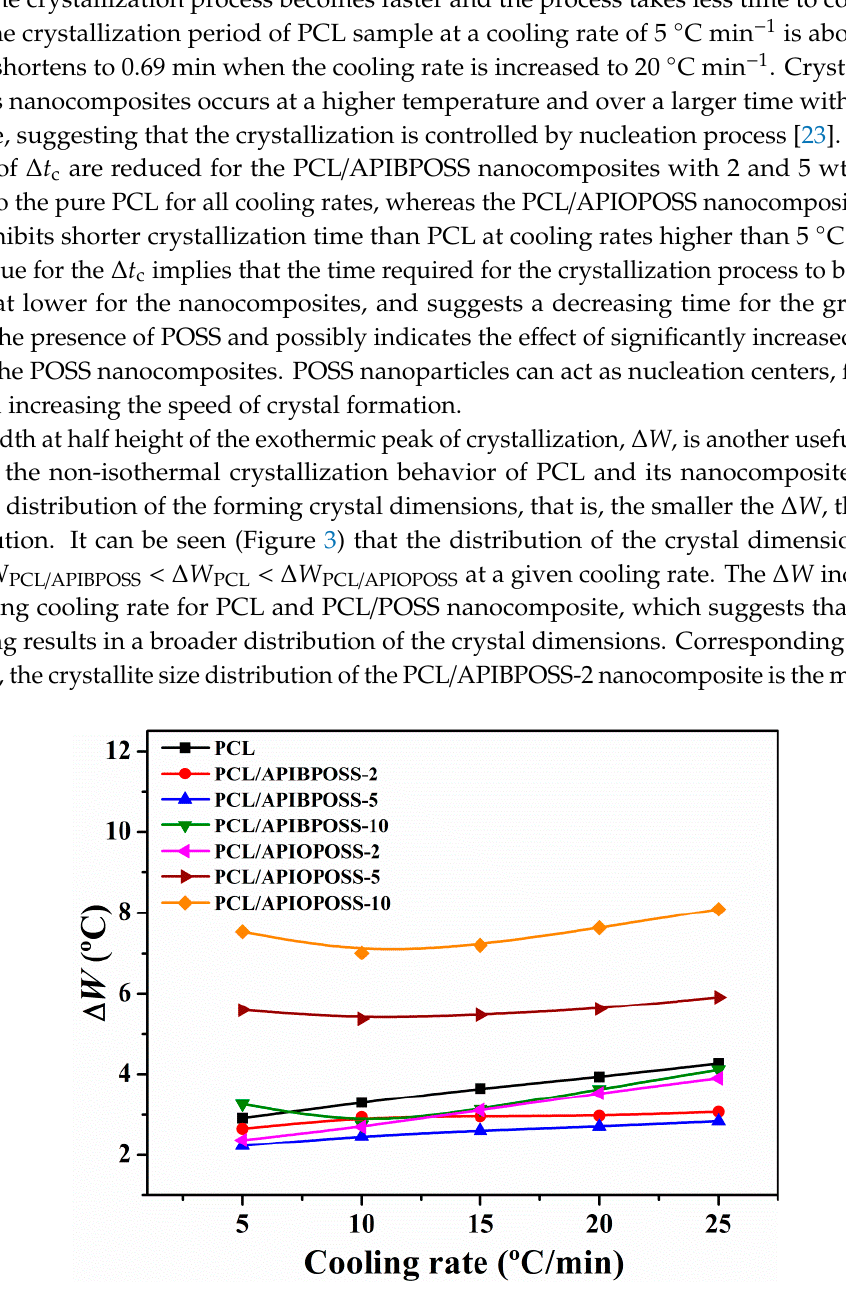
Figure 4. ( T k − T cp ) parameter as a function of cooling rate for PCL and PCL/POSS nanocomposites. Table 1 also shows the heat of crystallization ( Δ H c ). It is observed that the crystallization enthalpy is affected by both the addition of POSS and cooling rate. The values of Δ H c obtained for both neat PCL and PCL/POSS nanocomposite decrease with increasing the cooling rate, and the addition of POSS leads to a decrease in Δ H c , indicating that the crystallinity of PCL is affected by the incorporation of POSS.